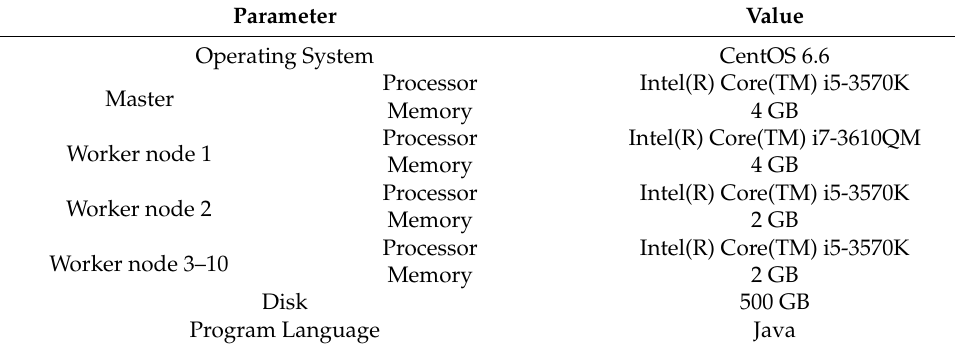
Table 3. Performance evaluation